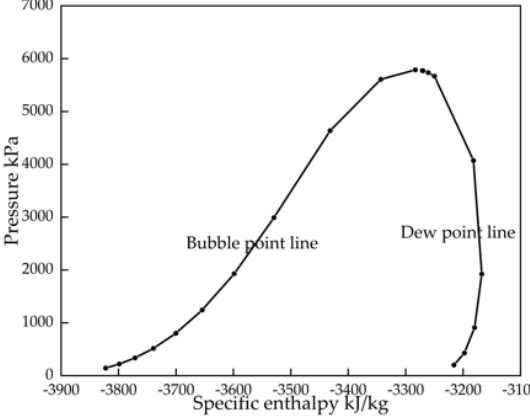
Figure 7. P-H phase diagram of the working fluid.